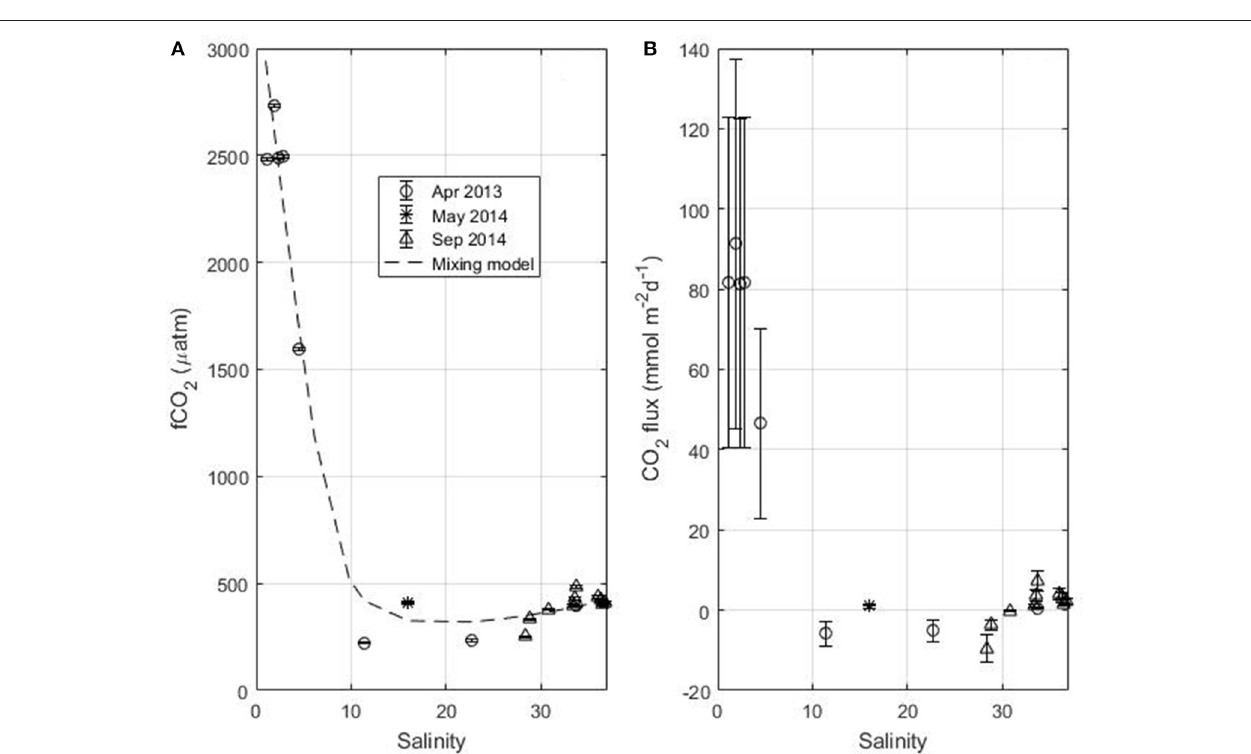
FIGURE 6 | (A) fCO 2 and (B) flux of CO 2 as a function of salinity along the Amazon transect in April 2013 and May 2014 and during Camadas Finas 5 in September 2014. The dash line in (A) represents fCO 2 calculated from the TA-SSS (Equation 2) and TCO 2 -SSS (Equation 3) relationships at a temperature of 28 ◦ C.